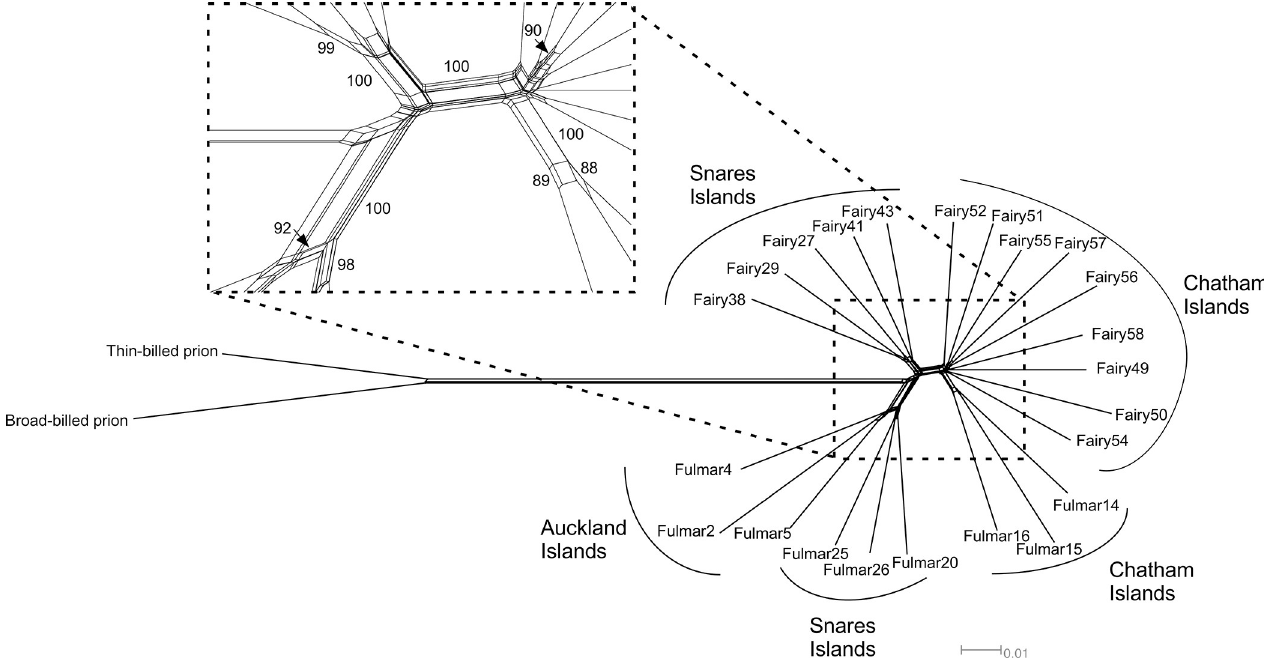
Fig 5. NeighborNet phylogenetic network derived from 30677 SNPs from 9791 ddRADseq loci. Bootstrap support values over 80% are shown.